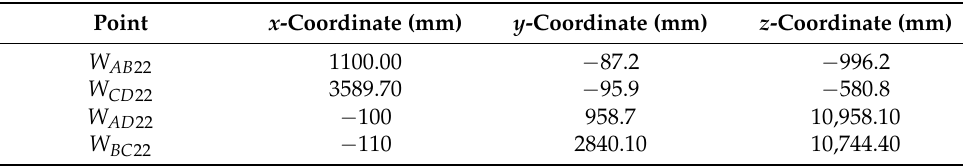
Table 5. The coordinates of the Γ 22 ’s